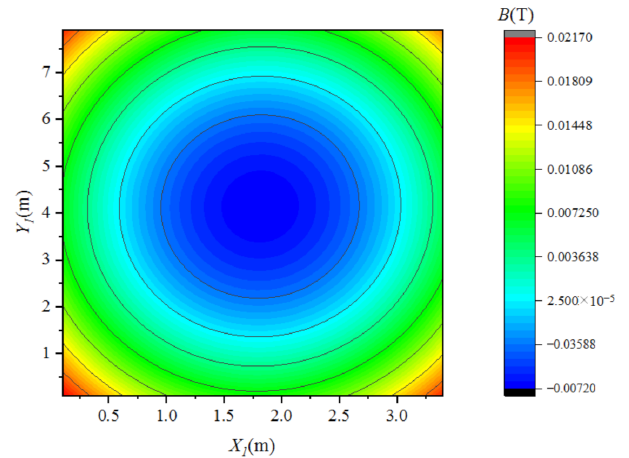
Figure 13. Magnetic field distribution on mesh plane 1 under +10/350 µ s and 50 kA.